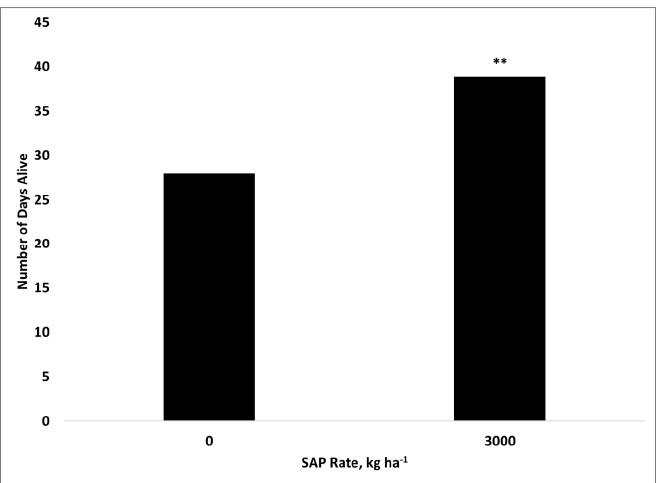
Figure 12. Seedling longevity, number of days alive, as a function of superabsorbent polymer (SAP) application averaged across 77 d of a glasshouse study with bottlebrush squirreltail and Siberian wheatgrass. Data were averaged across species and fertilizer placement depth (0 or 8 cm). The SAP rate of 3000 kg ha − 1 was placed in a band at a depth of 8 cm directly below the seed. Following SAP treatment, the soil was saturated once and then dried down naturally over the time of the study. Bars marked with “**” are highly significant at p = 0.0002.